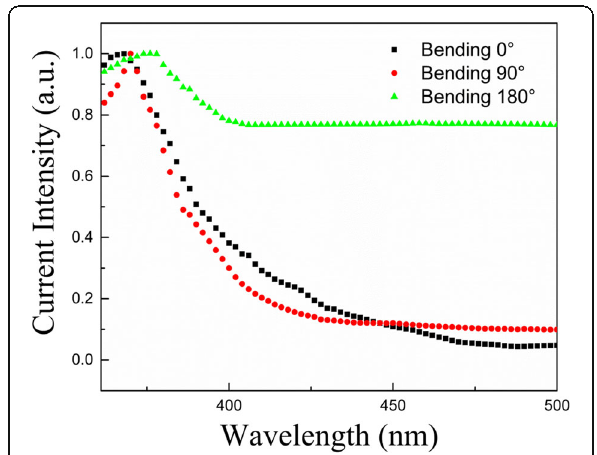
Fig. 5 The photoresponse wavelength of ZnO MW array PD at different bending angles (0°, 90°, and 180°)